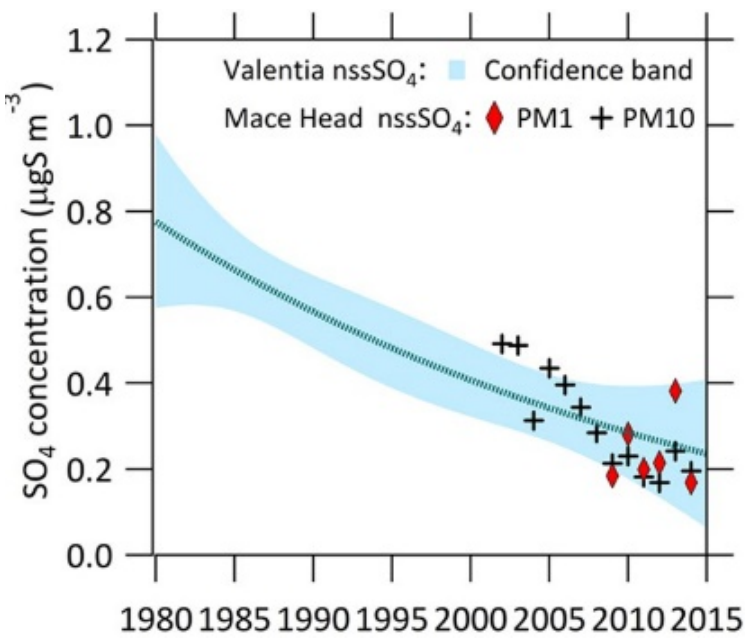
Figure 1. Sulphur air pollution trends. Non-sea salt sulphate aerosol (nss-SO 4 ) PM10, in the period 2001–2014, and nss-SO 4 PM1, in the period 2009–2014, (both in terms of µ g S m − 3 ) observed at Mace Head with the 95% confidence bands of an exponential trend curve fitted to non-sea-salt sulphate measured at Valentia Observatory over the time period superimposed; Figure reproduced from Gri- gas et al., 2017 [72].